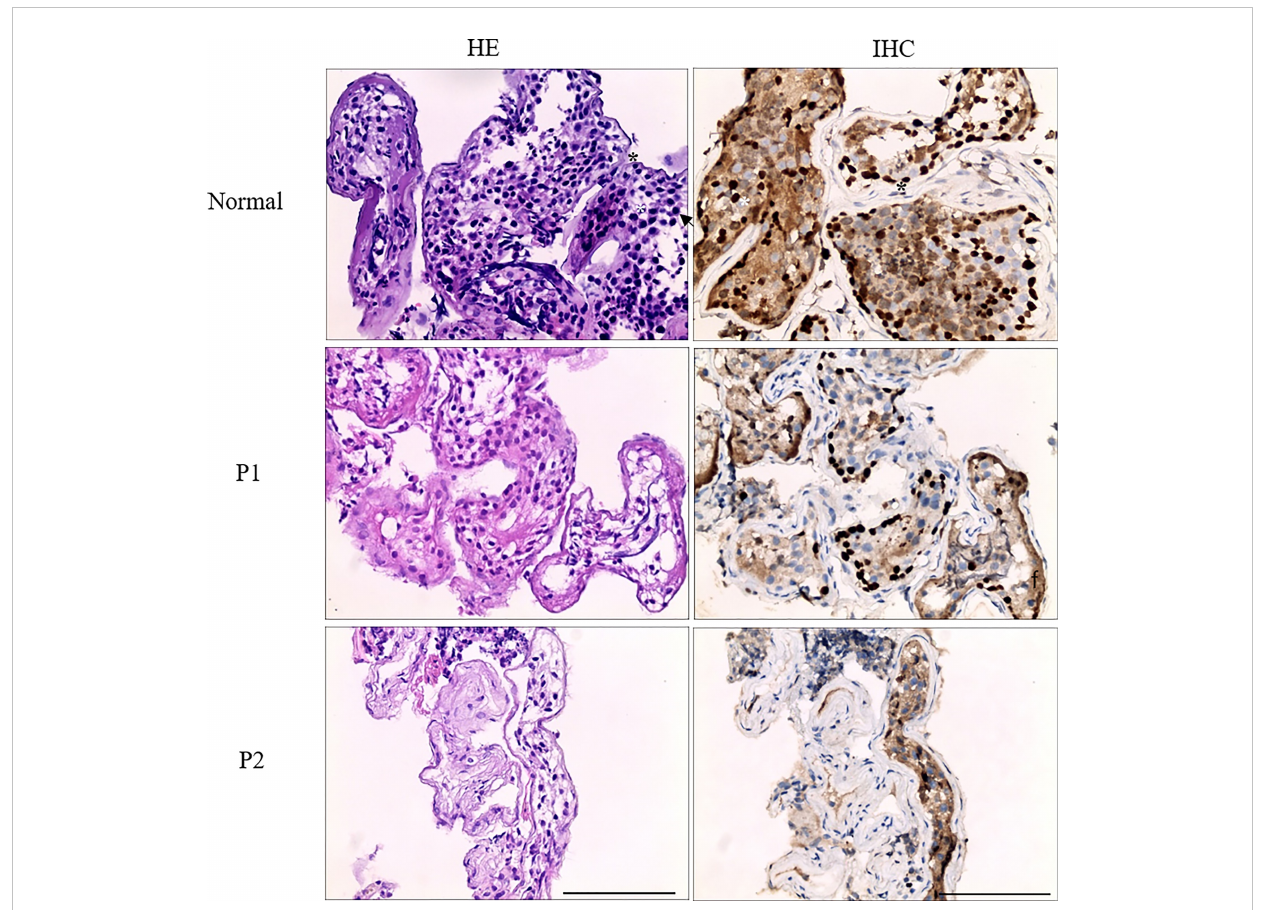
FIGURE 3 Analysis of testis biopsy samples from family 1 (P1, P2) and normal control. Primary spermatocytes and round spermatids were observed in the normal seminiferous tubules of the testis. Histologic sections showing a thicker basement membrane of the seminiferous tubules and poorly developed spermatocytes, no post-meiotic round spermatids or mature spermatozoa were observed in the seminiferous tubules of patient 1 and patient 2, in contrast with the normal testicular histology. Black asterisk denotes spermatogonia, white asterisk denotes spermatocytes, and arrowhead denotes round spermatids. Scale bar=100 m m.